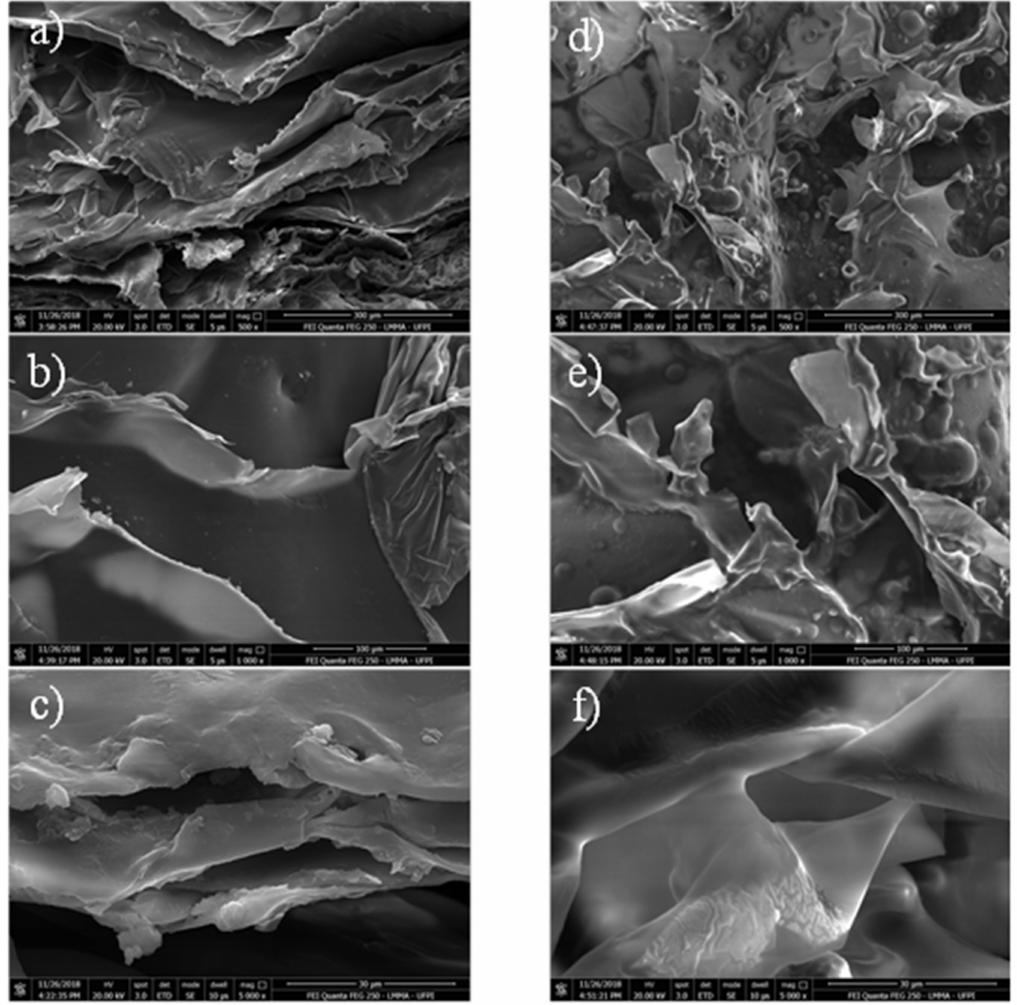
Figure 3. S canning electron microscope (SEM) images of chitosan gel (CG) ( a —300 µ m, b —100 µ m, and c —30 µ m) and chitosan gel with buriti oil (CGB) ( d —300 µ m, e —100 µ m, and f —30 µ